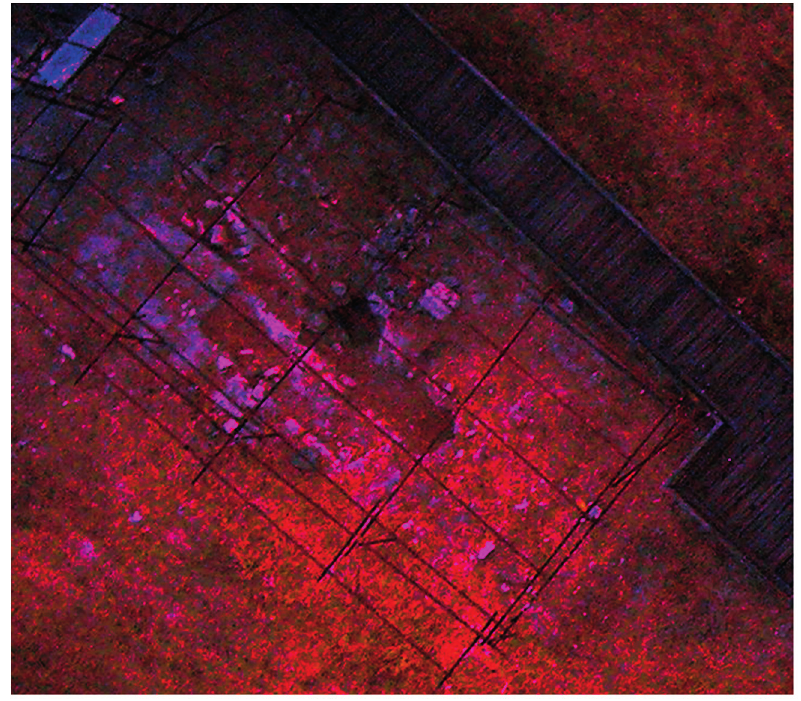
Figure 10. The filtered zoom of the picture in Figure 9 (central part, near the gangway).